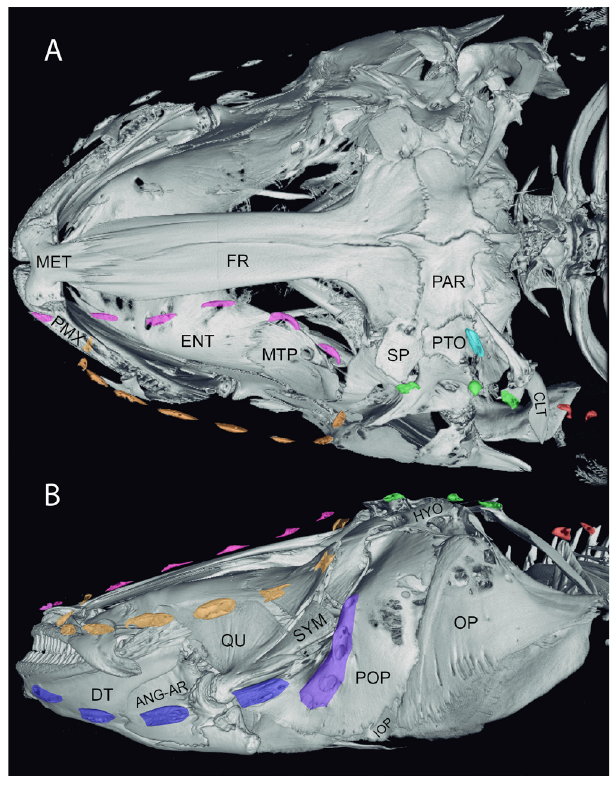
FIGURE 4 | Images of CT scan of the head of Electrophorus varii . A. dorsal and B. left lateral views of the cranium show the ossification of the lateral-line canals. The ossified segments of canals are marked by colors. Yellow: infraorbital canal; navy blue: mandibular canal; green: otic canal; purple: pre-opercular canal; pink: supraorbital canal; light blue: supratemporal canal; red: otic pit ossicles. ANG-AR: Angulo-articular; CLT: cleithrum; DT: dentary; ENT: entopterygoid; FR: frontal bone; HYO: Hyomandibular; IOP: interopercle; MET: mesethmoid; MTP: metapterygoid; OP: opercle; PAR: parietal; PMX: premaxila; POP: preopercle; PTO: pterotic; QU: quadrate; SP: sphenotic; SYM: sympletic. Specimen size = 82 cm